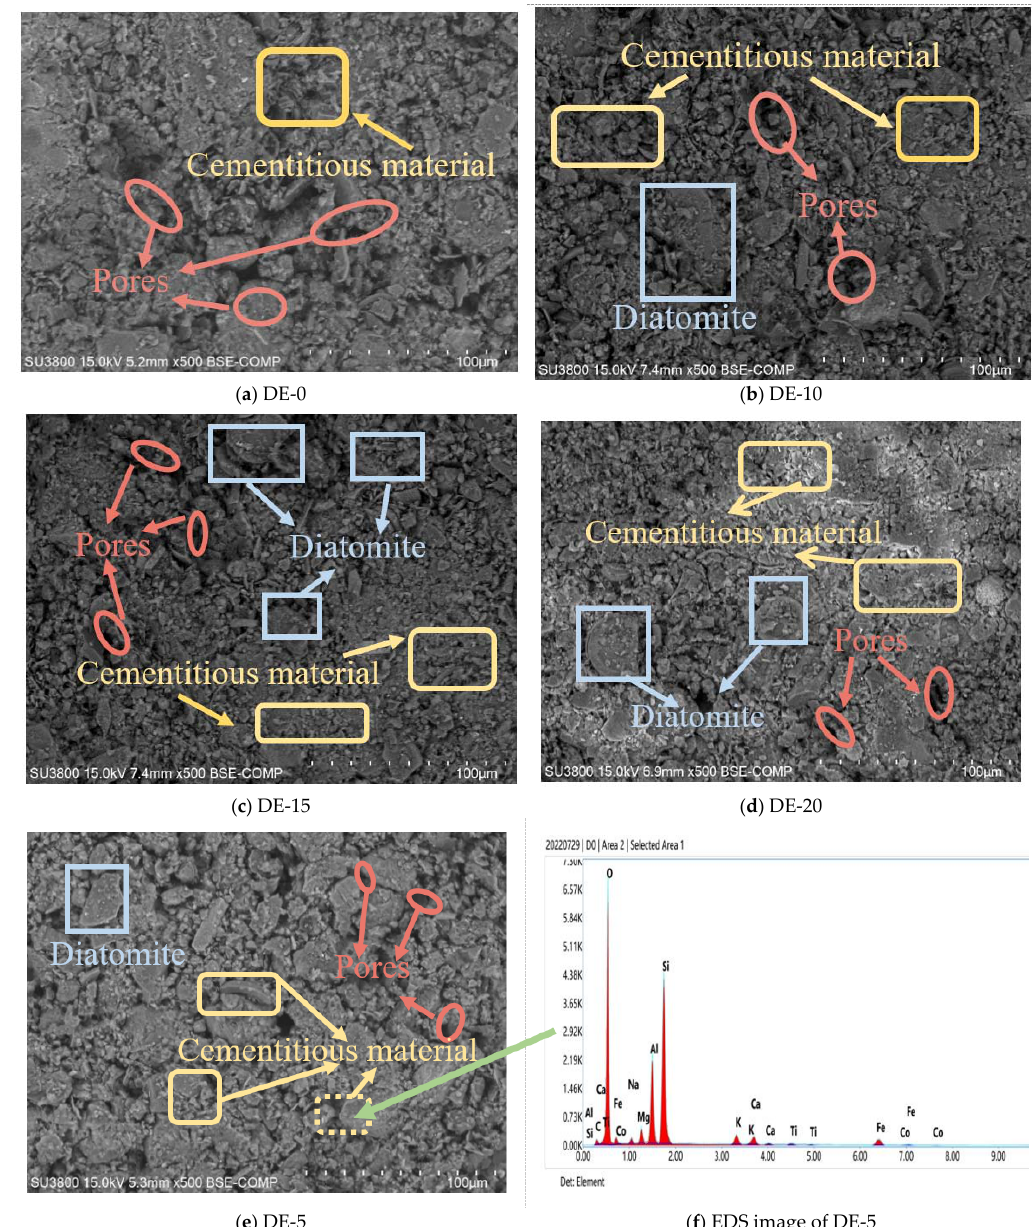
Figure 10. BSE photos and EDS images of coastal marine soil specimens modified with different amounts of diatomite. ( a ) BSE image of DE-0,500 times, ( b ) BSE image of DE-10,500 times, ( c ) BSE image of DE-15,500 times, ( d ) BSE image of DE-20,500 times, ( e ) BSE image of DE-0,500 times, and ( f ) EDS image of